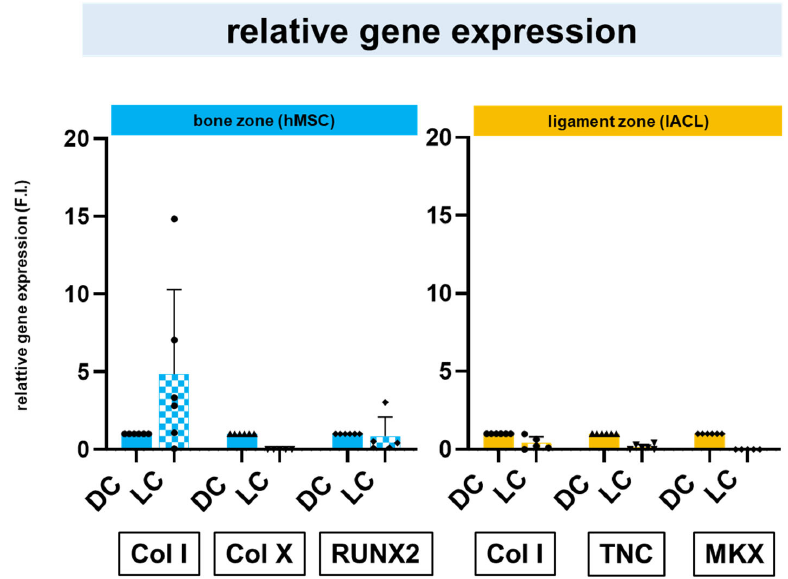
Figure 6. Relative gene expression of bone- and ligament-related extracellular matrix components and transcription factors. Normalized (F.I. = fold induction) gene expression of collagen type I (Col I), collagen type X (Col X) and the transcription factor runt-related protein (RUNX)2 was evaluated for the directly seeded (DC, set to 1) or longer (LC) pre-cultivated (osteogenically differentiated) hMSC spheroids on the bone zone, while that of Col I , tenascin C (TNC) and the transcription factor Mohawk (MKX) was analyzed for the directly seeded or the longer pre-cultivated lACL spheroids. Bone and ligament zones were separated before evaluation. Five independent experiments analyzed with ROUT (1%) outlier test and one-way ANOVA showed no significant differences.